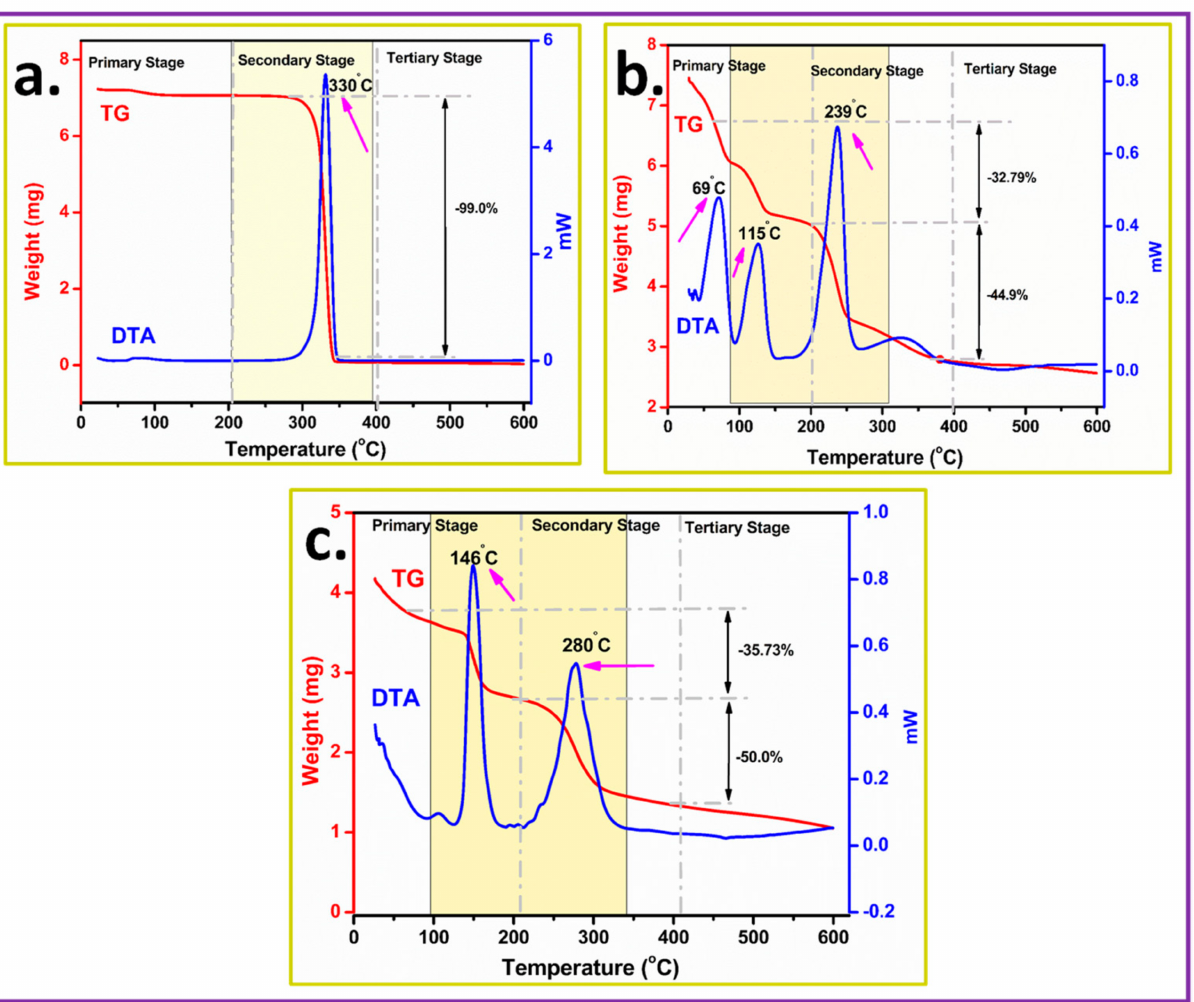
Figure 3. ( a ) The TG-DTA curve of the hydrogen bond acceptor (ChCl), ( b ) hydrogen bond donor (Zr(NO 3 ) 4 · 5H 2 O and ( c ) DES prepared from ChCl:Zr(NO 3 ) 4 · 5H 2 O=